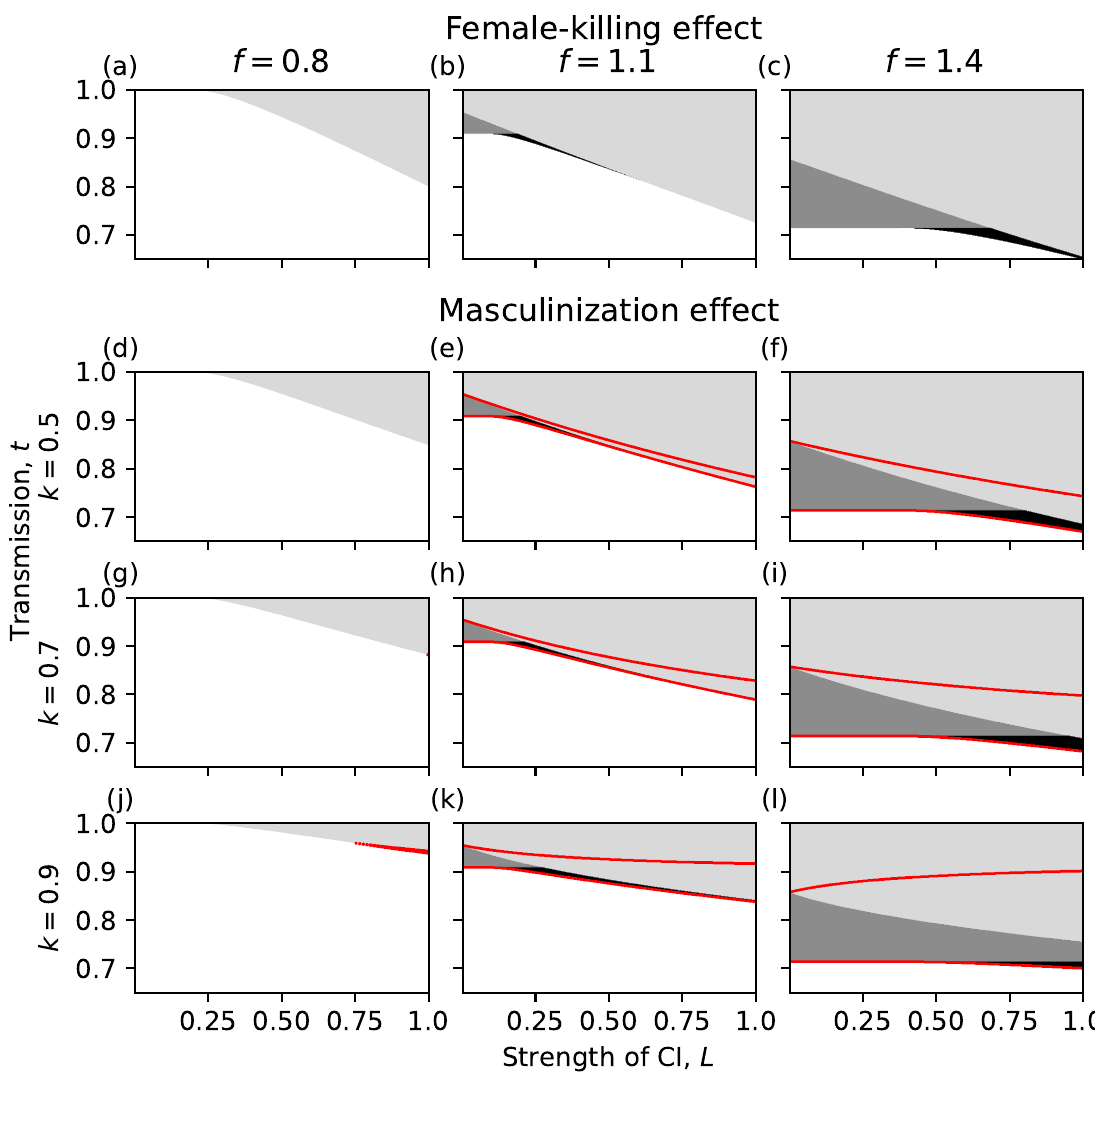
Figure 6. Classification of equilibria of the haplodiploid models across parameter space. Columns from left to right with f = 0 . 8 , f = 1 . 1 and f = 1 . 4 . First row: female-killing effect; other rows: masculinization effect model with different values of k . White: only the trivial equilibrium at zero. Light grey: non-trivial stable equilibrium with 1 / 2 < ˆ p F ≤ 1 . Dark grey: ˆ p F ≤ 1 / 2 without invasion threshold. Black: ˆ p F ≤ 1 / 2 with invasion threshold. The red lines outline two thresholds, between which ˆ p M ≤ 1 / 2 . Note that the vertical t -axes span only high values, where non-trivial equilibria